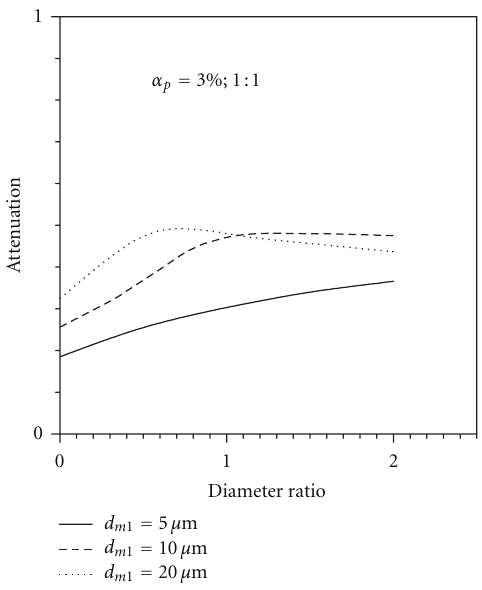
Figure 14: Nondimensional attenuation as function of particle diameter and loading distribution [ α p 2 : α p 1 ] for two sets of particles (10 μ m [ d m 1 ] and 20 μ m [ d m 2 ] particles), reference motor, acceleration nullified.